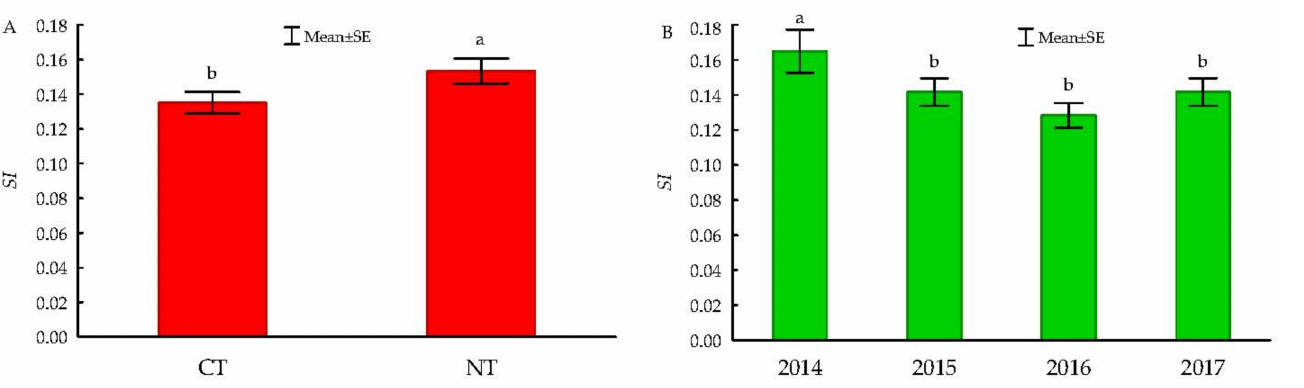
Figure 7. Simpson’s dominance index ( SI ) of weed community in winter oilseed rape crop depending on tillage system ( A ) (mean for 2014–2017) and years of research ( B ). CT—Conventional tillage; NT—No-tillage. Different letters denote significant differences ( p ≤ 0.05). The same letter means not significantly different values.